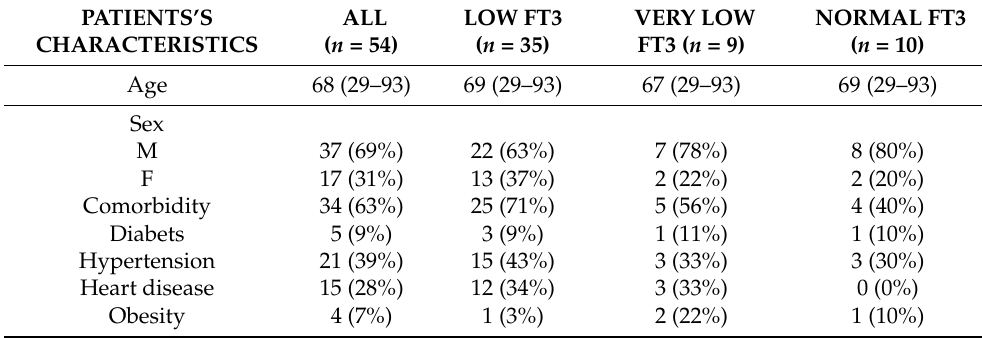
Table 1. Epidemiological and clinical characteristics of COVID-19